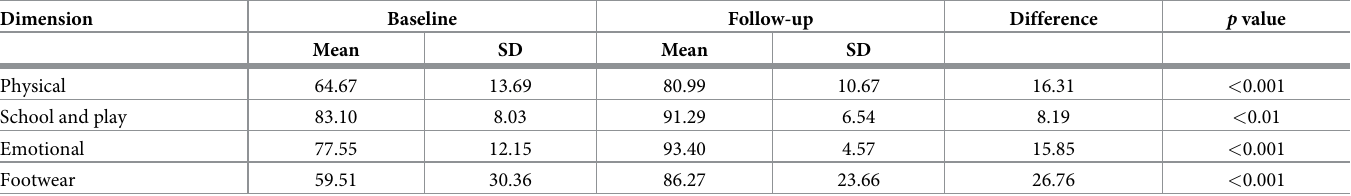
Table 2. Scale descriptives for Oxford Ankle Foot Questionnaire for children: Comparison across time before surgical correction and after the screw removal. Dimension Baseline Follow-up Physical < 0.001 School and play Emotional